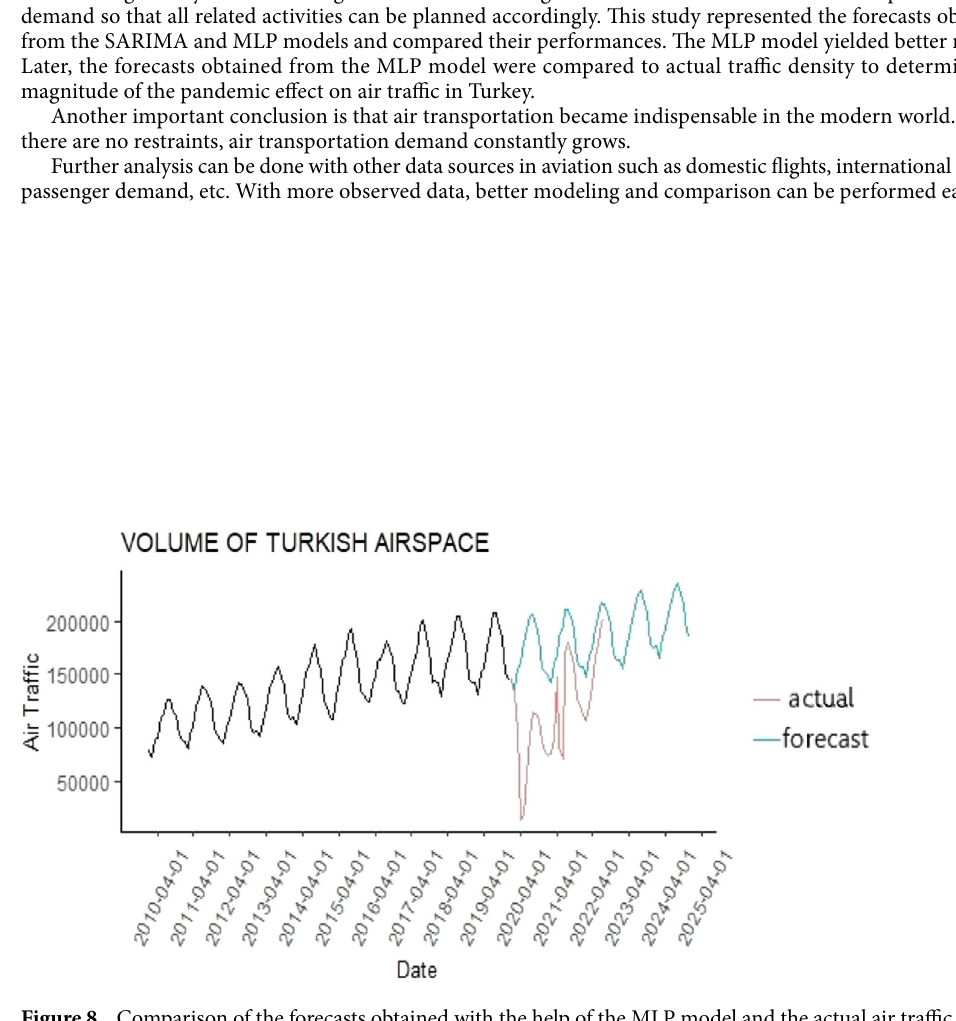
Figure 8. Comparison of the forecasts obtained with the help of the MLP model and the actual air traffic